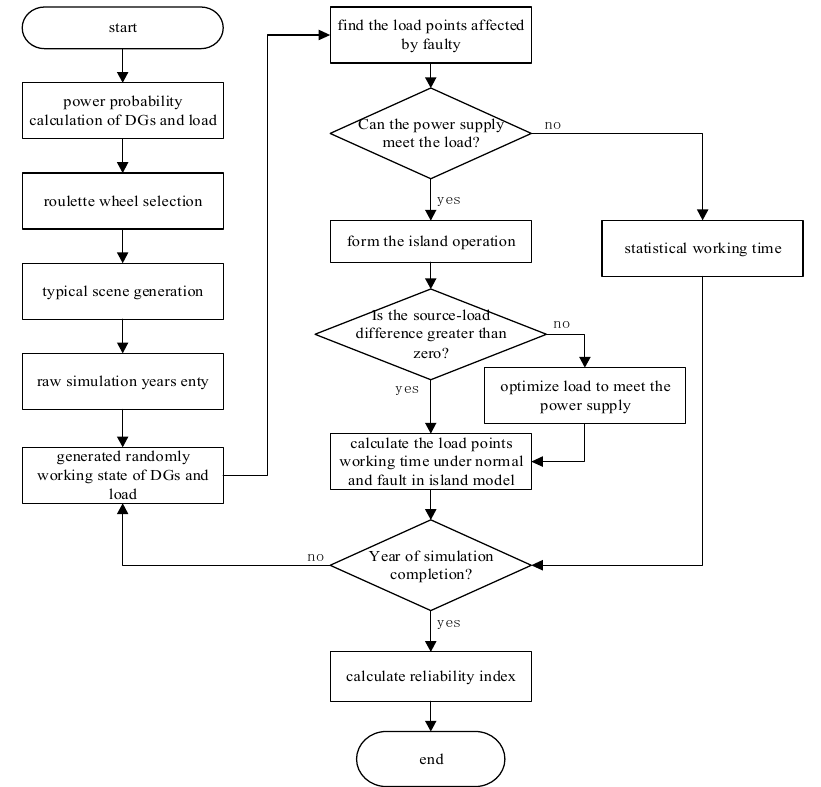
Figure 2. Simulation process of reliability calculation.